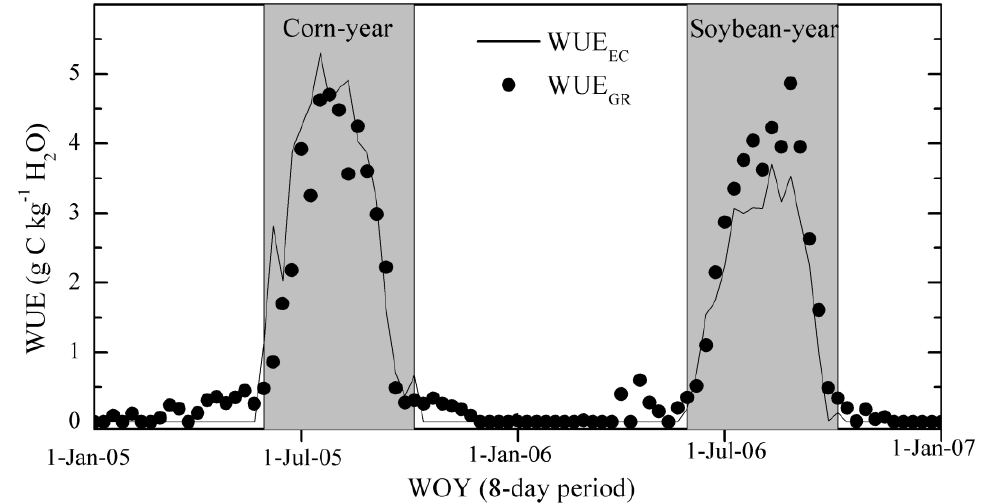
Figure 5. Seasonal dynamics in ecosystem water use efficiency from flux tower measurements (WUE EC ) and estimates based on MODIS EVI data (WUE GR ) at the flux tower site US-Bo1 during 2005 (corn) and 2006 (soybean), with the growing seasons displayed in gray.